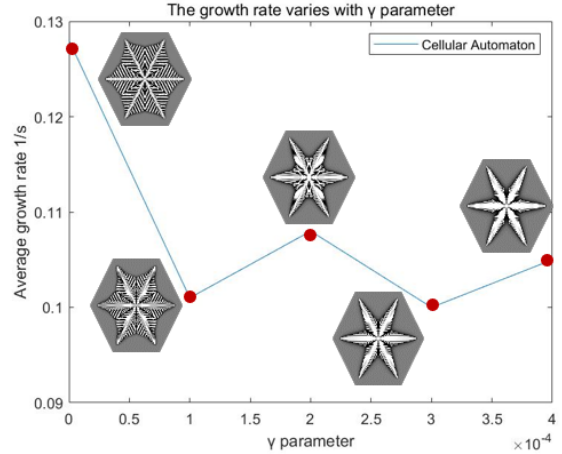
Figure 18. The growth rate varies with the γ parameter by CA.